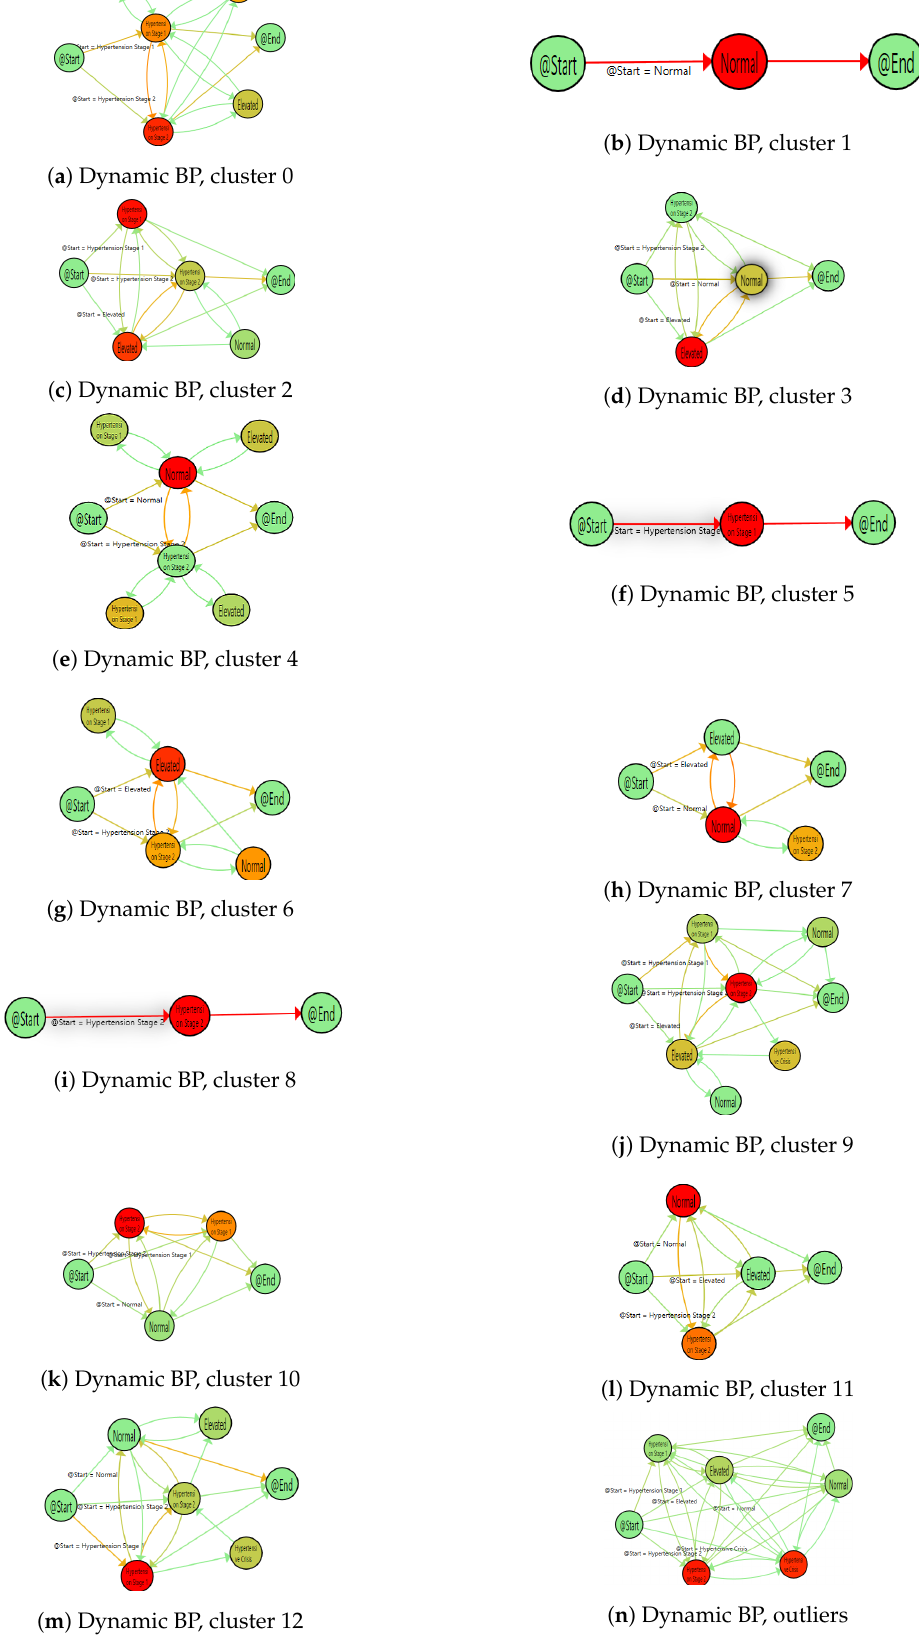
Figure 4. Dynamic characterisation of